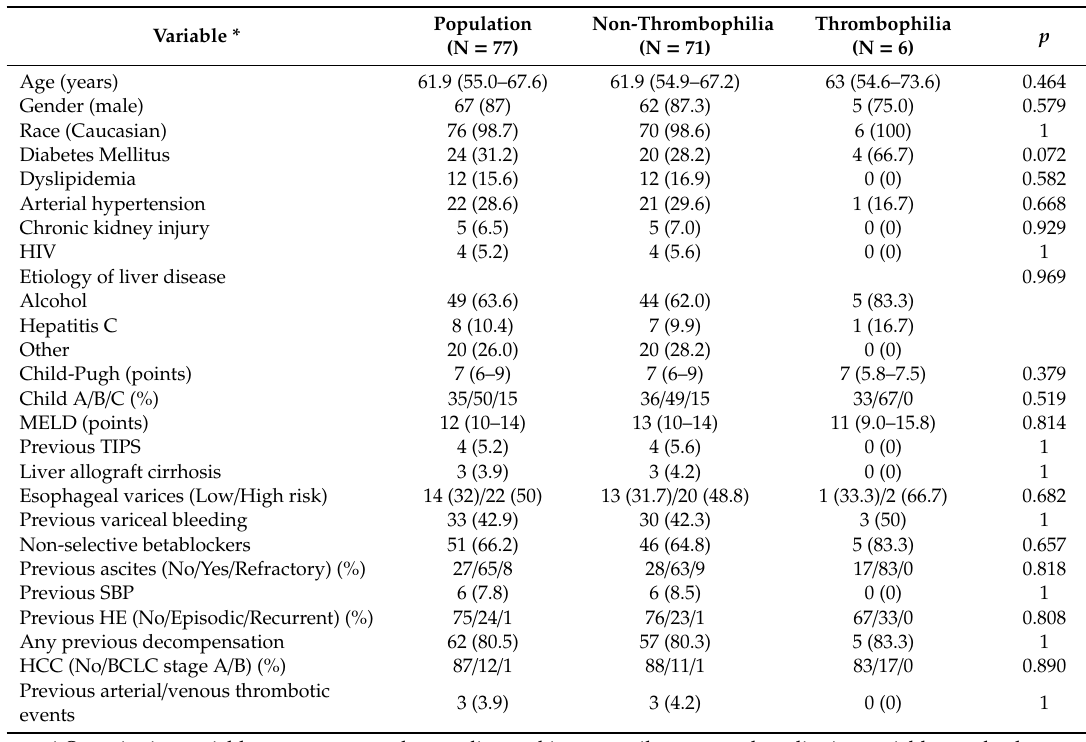
Table 2. Clinical and epidemiological profile of patients in the whole cohort and in patients with and without